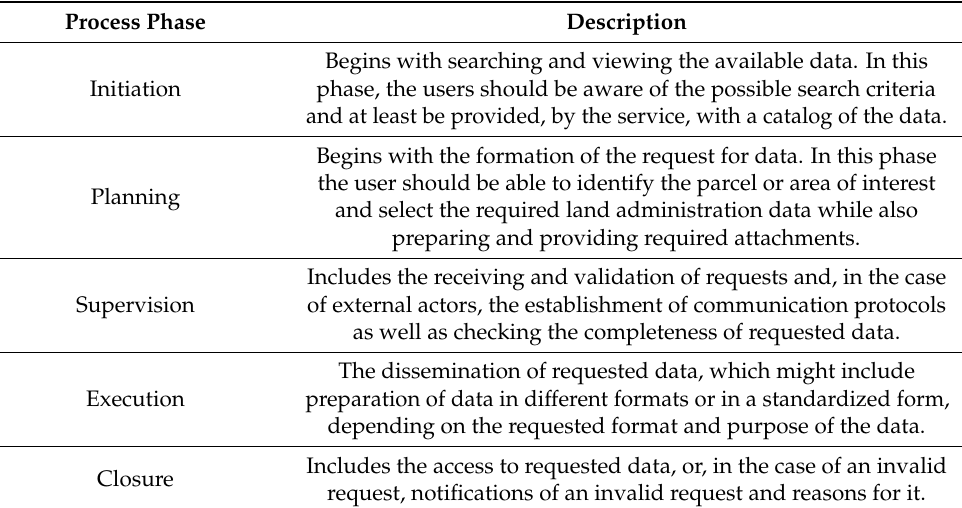
Table 3. Description of the identified process